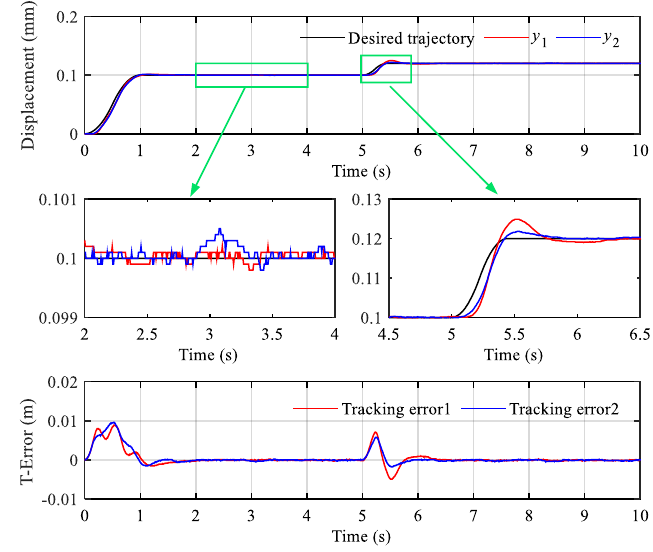
Figure 11. Position synchronization control results of the step signal.